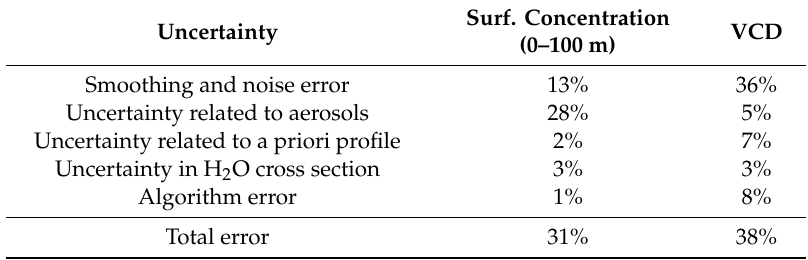
Table 2. Averaged error budget of retrieved water vapor surface concentrations and VCDs. Surf. Uncertainty